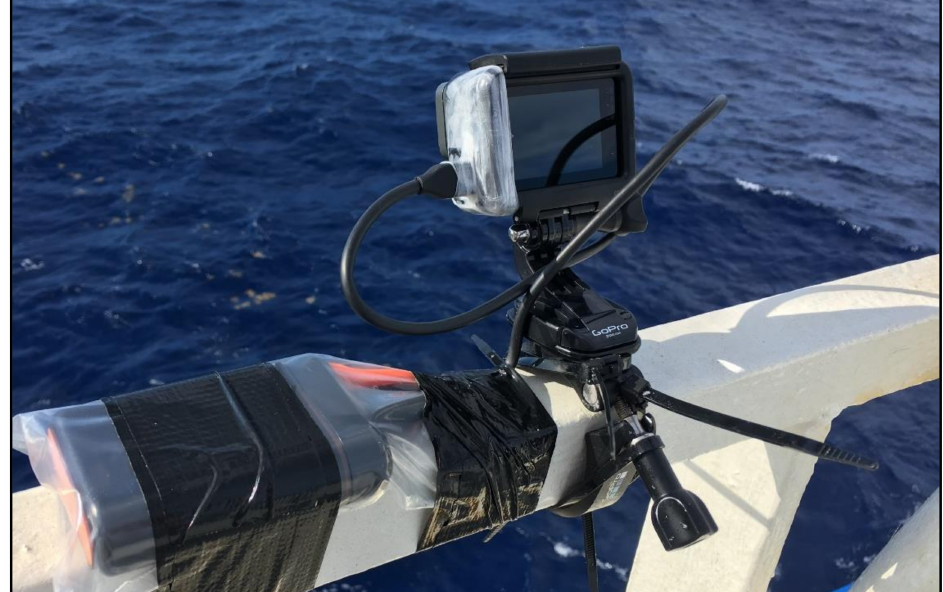
Figure 1. Camera set-up: a GoPro ® Hero6 Black is clamped to the vessel starboard and/or portside railing. A power bank is attached for longer battery endurance. The camera records to a 128 GB microSD card, which provides enough storage for one day of photos at 2 s interval and 4000 × 3000 pixels resolution.